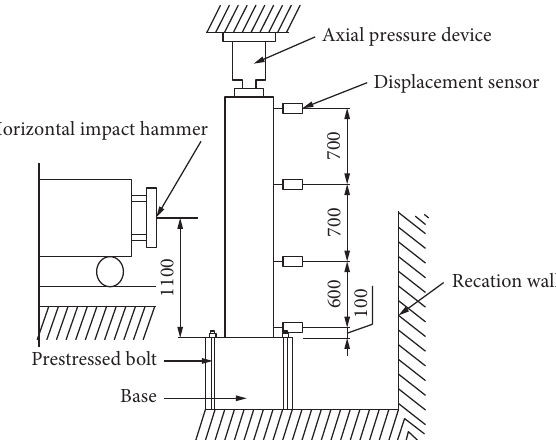
Figure 8: Distribution of the pier displacement measurement